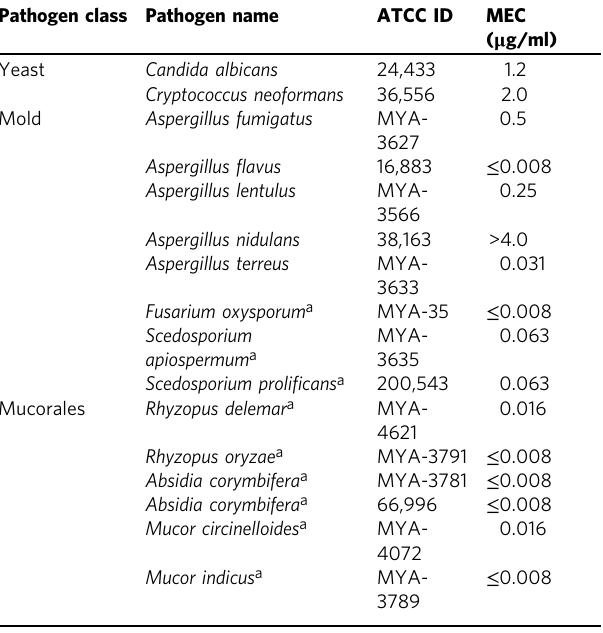
Table 1 Fungicidal activity of